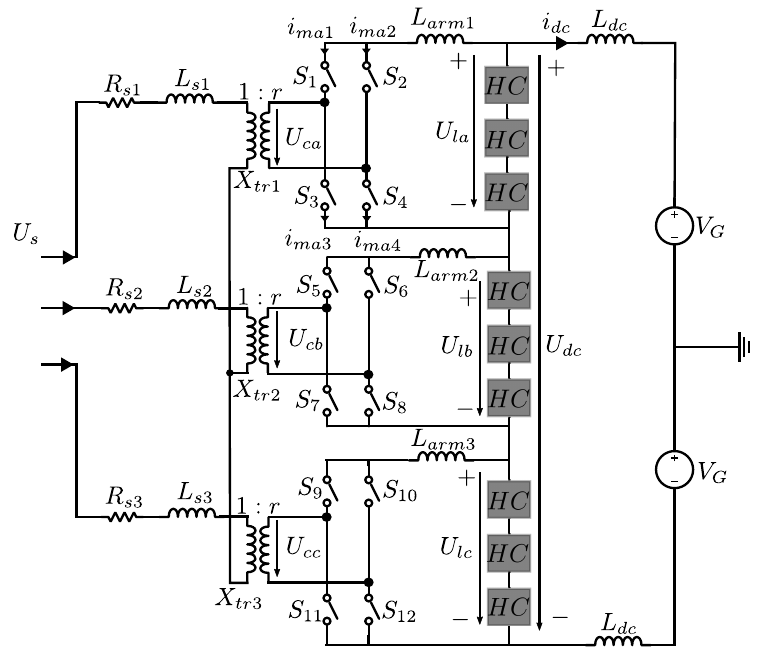
Figure 21. PHMC topology. HC are half-bridge (HB) cell stacks. The cell stack is used to produce the absolute value of a sinusoidal wave, and then its polarity will be rotated to produce the required AC by the IGBT